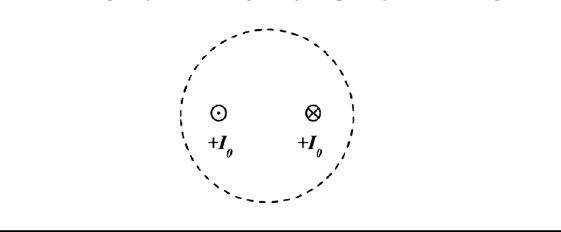
FIG. 1. The parallel problems used for this research. The electricity version presented two fixed point opposite charges, enclosed by a Gaussian spherical surface. The magnetism version gave two conventional currents flowing in opposite directions, enclosed by an Amperian circular